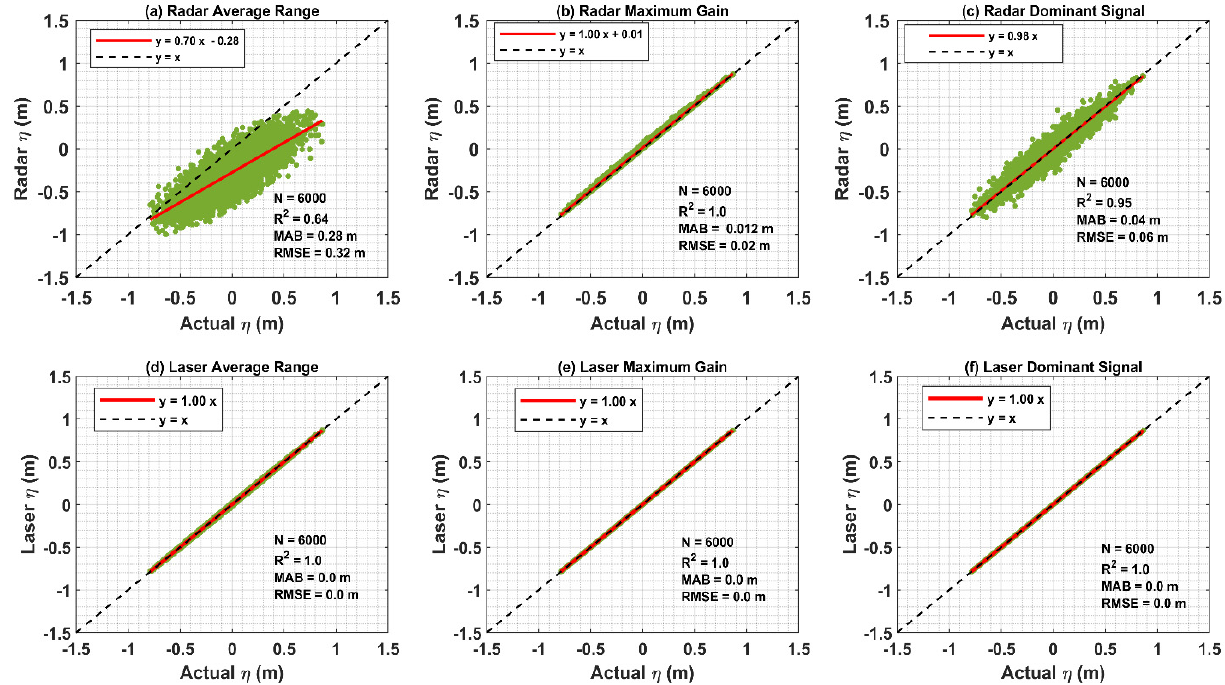
Figure 5. Comparisons of actual surface elevation with average range ( a , d ), maximum gain ( b , e ), and dominant signal ( c , f ) estimated from the Radar and Laser simulations for a sea state with a significant wave height ( H m 0 ) and peak frequency ( f P ) of 1.1 m and 0.22 Hz,